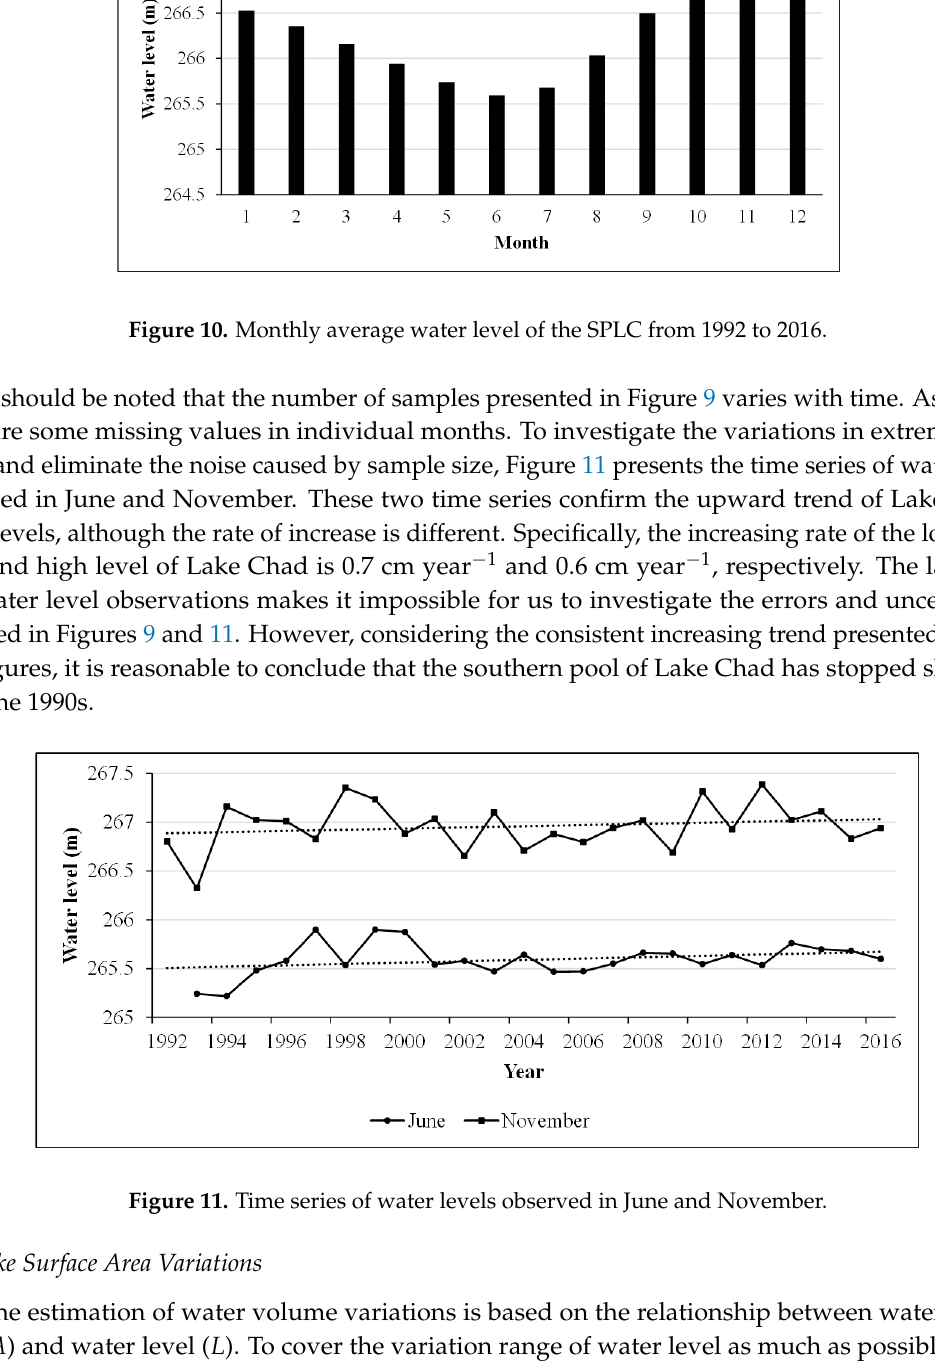
Figure 9. Variations of water levels retrieved from the combination of Hydroweb, GRLM/OSTM and DAHITI.